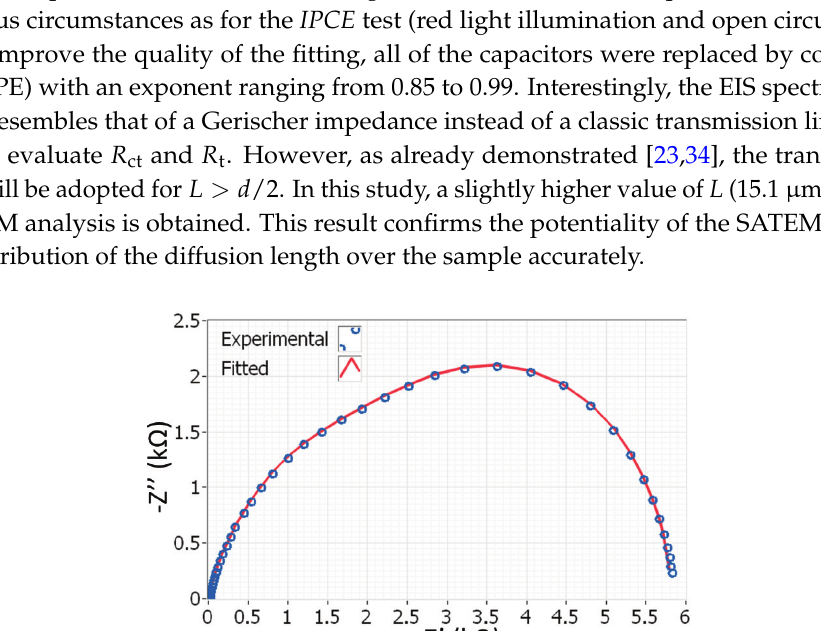
Figure 7. ( a ) Fitting of the η IPCE ( b ) Estimated η sep and calculated light harvesting and collection efficiencies for the both the PE and the CE side.